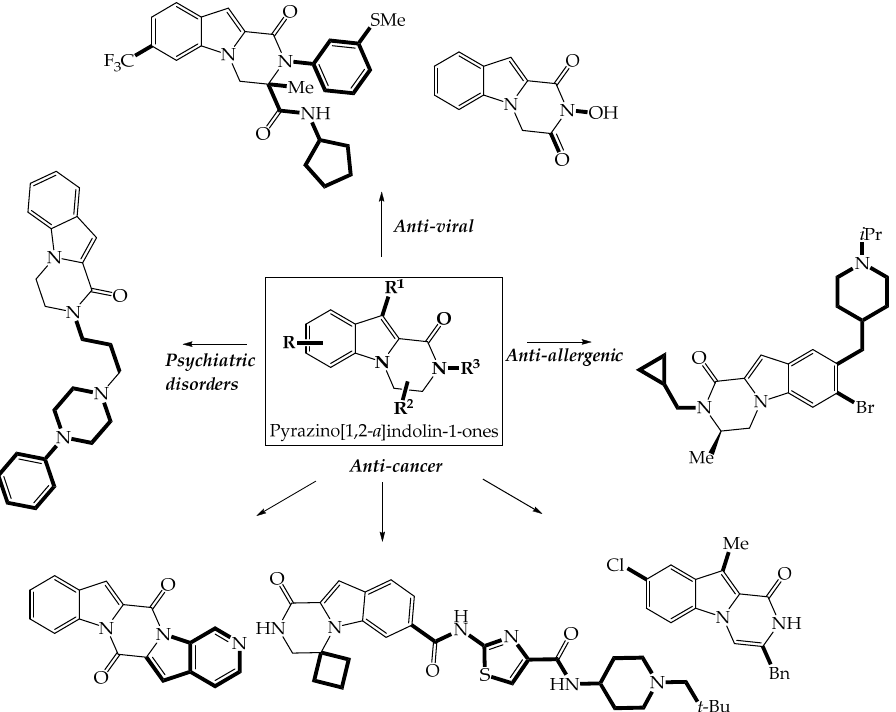
Figure 4. Overview of pyrazino[1,2- a ]indol-1-ones having biological properties.